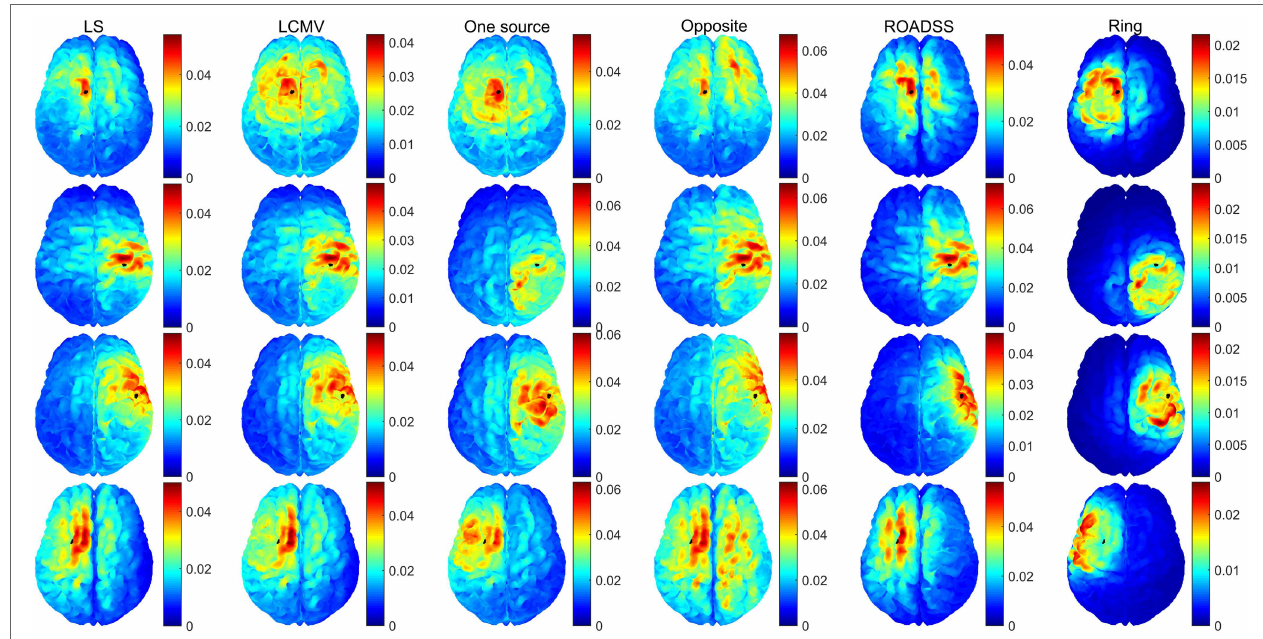
FIGURE 9 | The same as in Figure 8 for the 256 EGI electrode net .